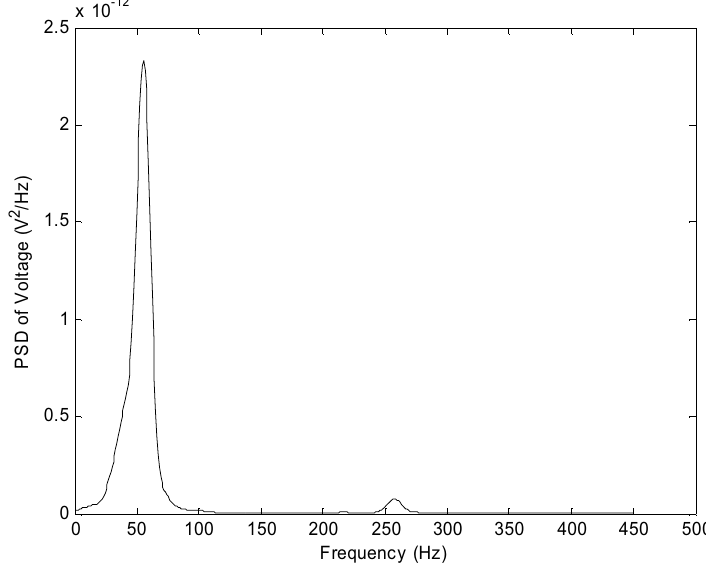
Fig. 14. Frequency spectrum of the PZT sensor voltage of Fig. 13.